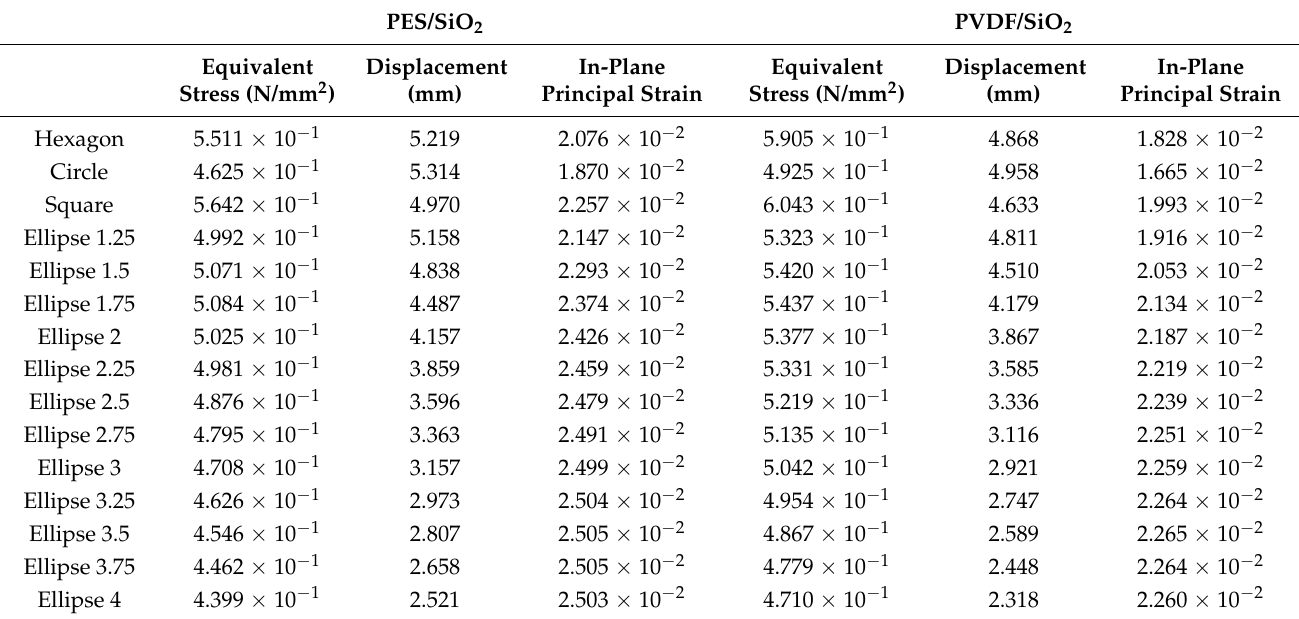
Table 5. Numerical analysis results of PES/SiO 2 and PVDF/SiO 2 membranes in different